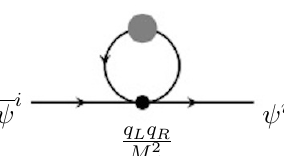
Figure 3 . One-loop fermion self-energy induced by the perturbative four-fermion interactions of equation (2.23), with the grey blob representing the dynamical fermion mass M dyn